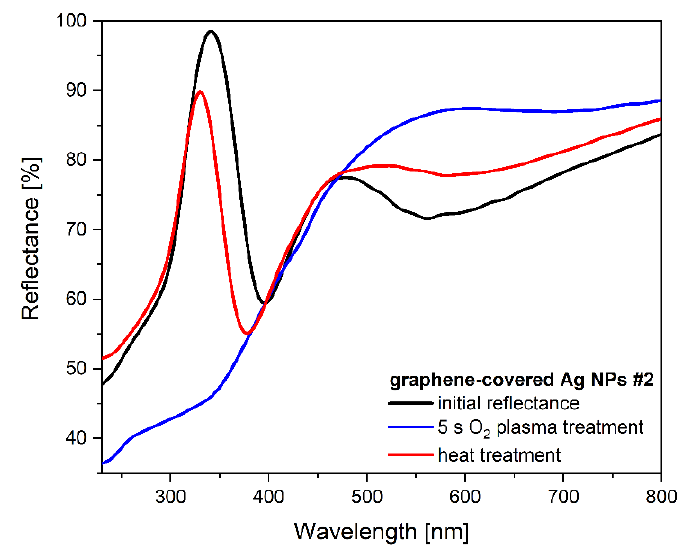
Figure 3. Optical reflectance spectra of the graphene-covered Ag NP sample #2 before (black) and after (blue) O 2 plasma treatment. The LSPR is recovered (red) by annealing at 400 °C.